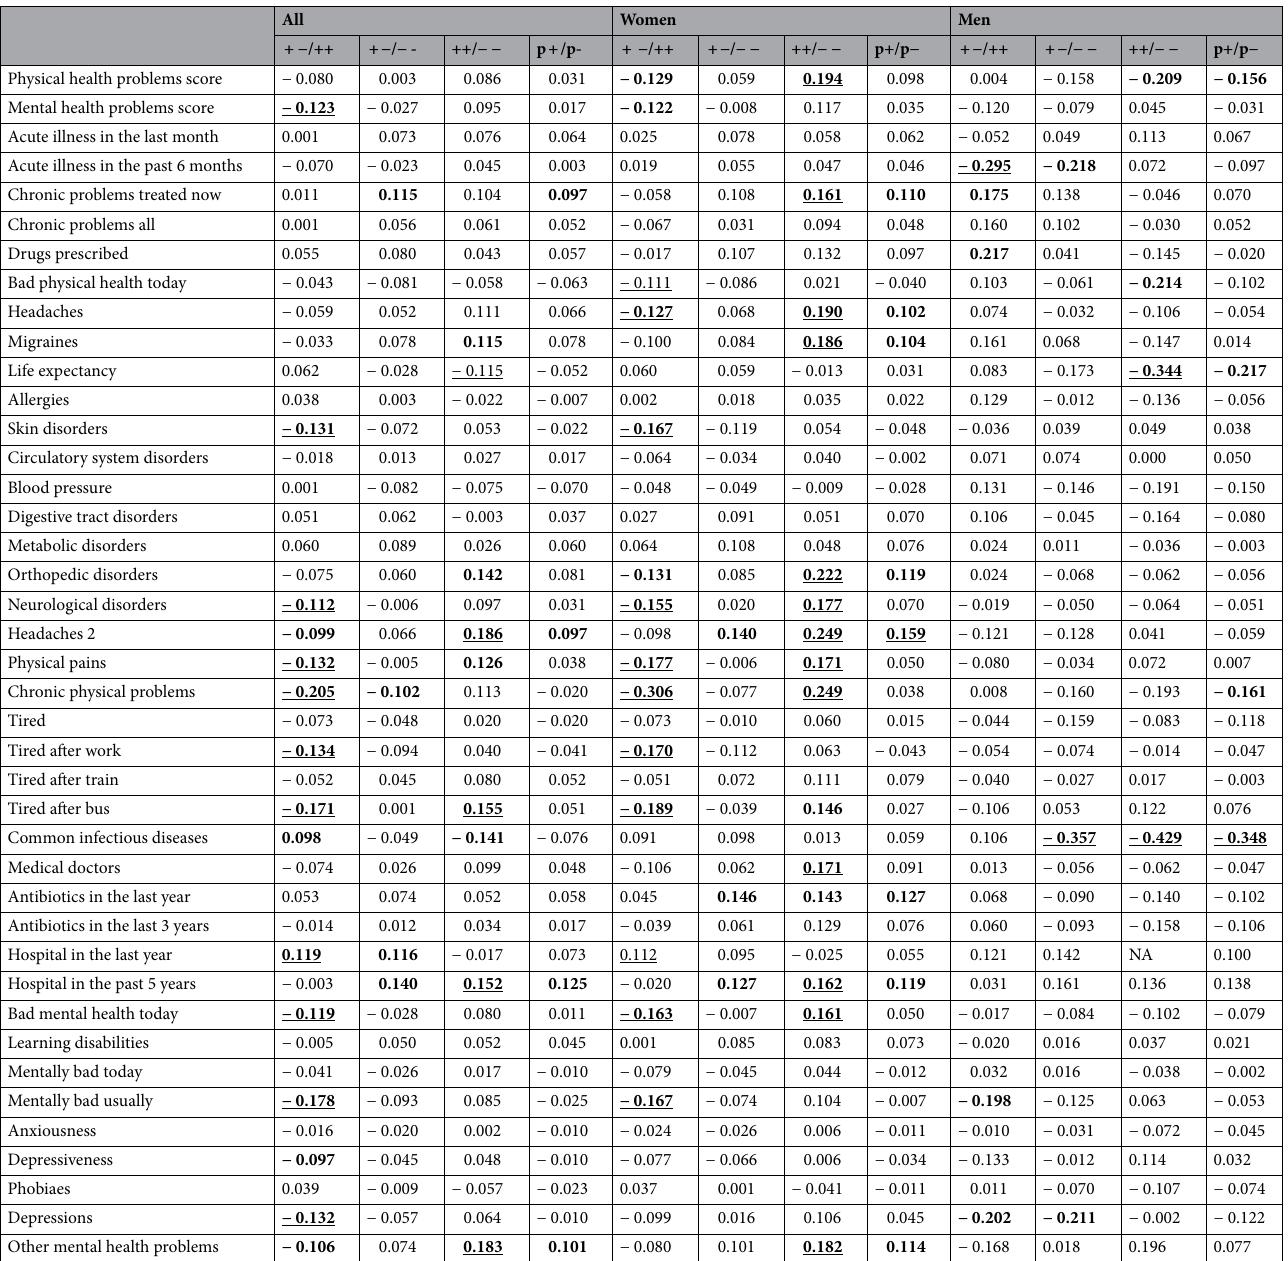
Table 2. Effects of RHD genotype and phenotype on physical and mental health problems scores and their source variables. This table shows the direction and strength of particular effects (Taus) measured with